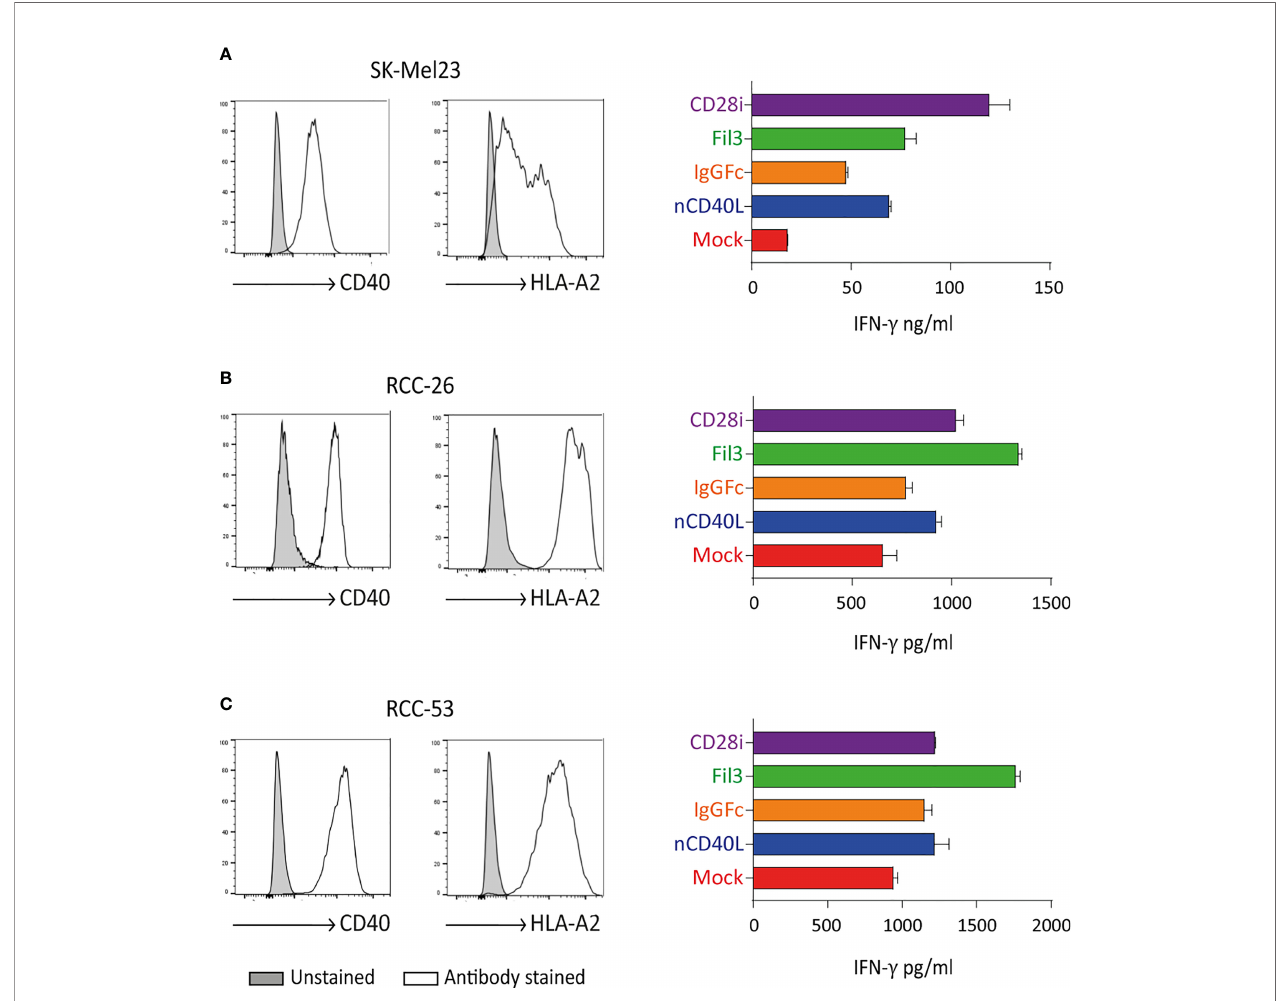
FIGURE 10 | CD40L:CD28 CSPs improve T cell cytokine secretion. TCR-T58 tyrosinase-speci fi c T cells and TCR53 RCC-speci fi c T cells expressing the CD40L: CD28 CSPs were thawed and used immediately without re-activation in co-cultures at a T cell to target cell ratios of 1:10 with tyrosinase-positive target cells SK- Mel23 for TCR-T58 T cells (A) , and RCC-26 and RCC-53 RCC tumor cell lines for TCR53 T cells (B, C) . All target cells expressed CD40 and HLA-A2 endogenously (shown as histograms). IFN- ү was measured in supernatants of co-cultures by ELISA. Shown are mean values of duplicates from one representative experiment repeated 2 times. Error bars are the standard